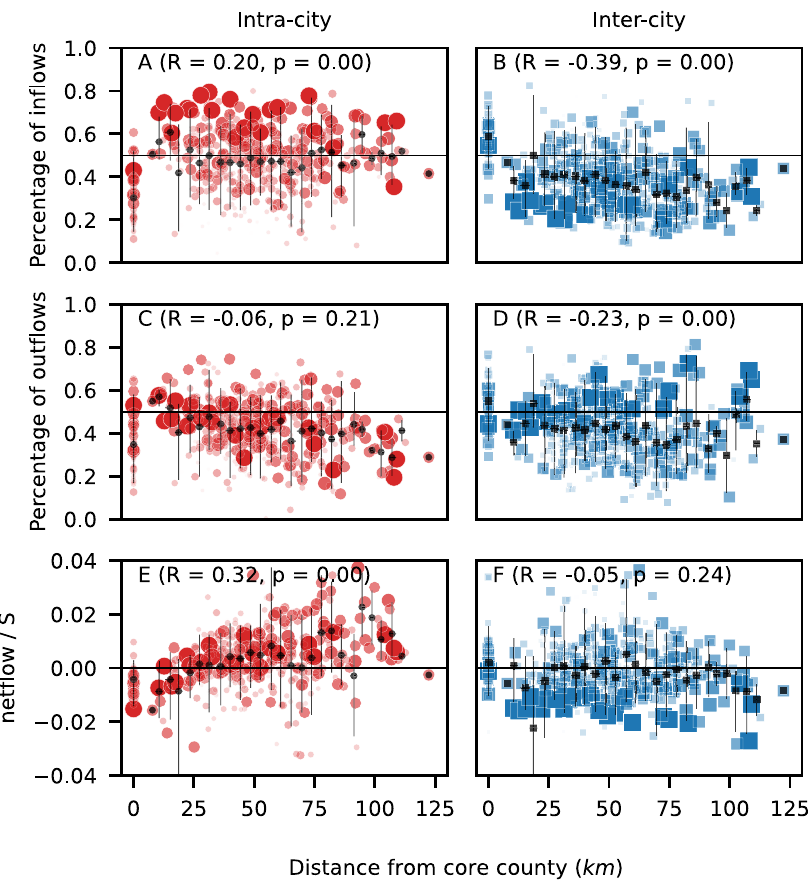
Fig. 3 | Roles of intra- and inter-city fl ows in driving the heterogeneous popu- lation growth of cities. We de fi ne the core county as the one with the highest population density, and we plot the percentage of in fl ows due to intra- ( A ) and inter-city fl ows ( B ) of each county within a city as a function of its distance to the corecounty.Thepercentageofout fl owsduetointra-andinter-city fl owsareshown in ( C ) and ( D ), respectively. The positive correlation of the relative growth with distanceduetointra-city fl owsin( E ),alongwiththelackofcorrelationduetointer- city fl owsin( F ),indicatesthatintra-city fl owsaremainlyresponsibleforincreasing